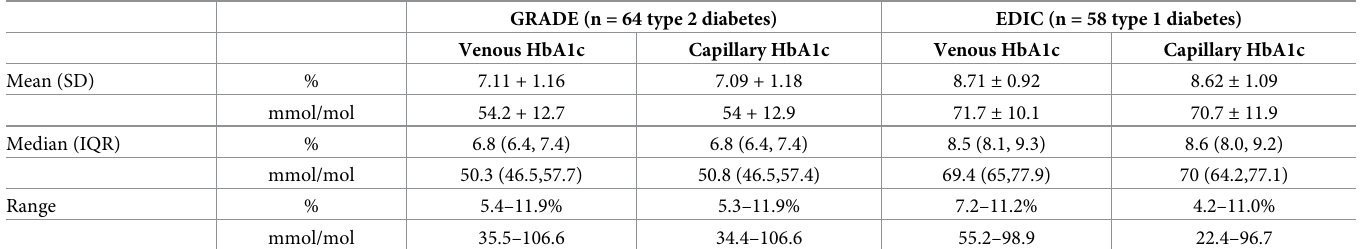
Table 1. Venous and capillary HbA1c results.